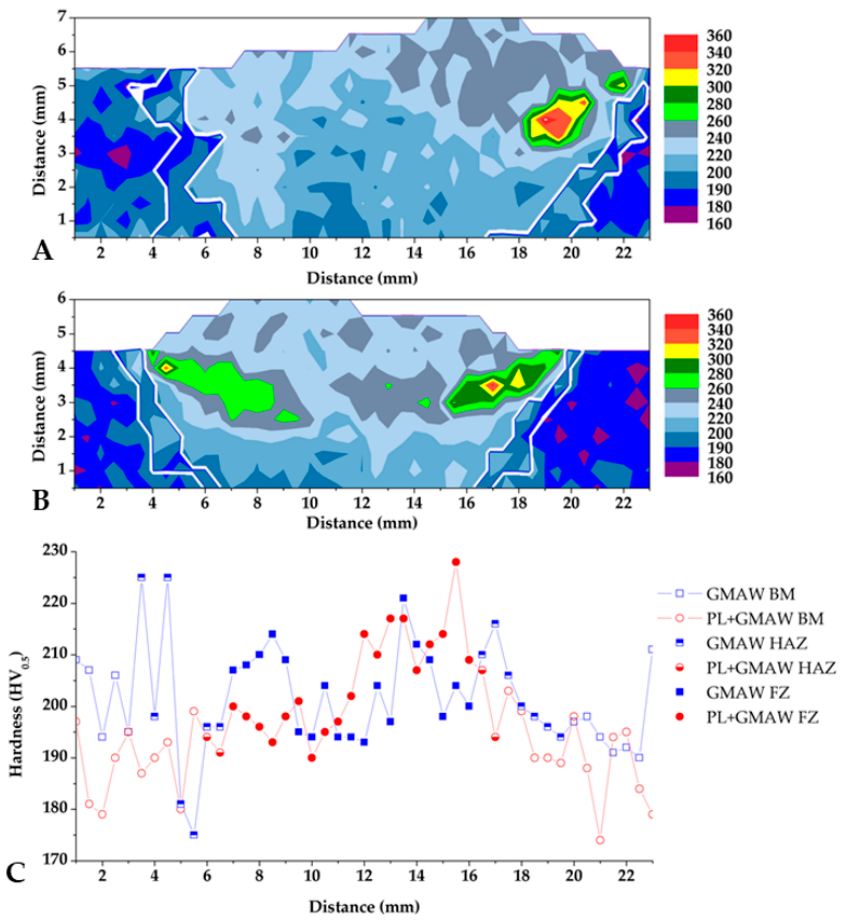
Figure 6. Microhardness mapping of GMAW ( A ), PL + GMAW ( B ), and the bottom-line profile ( C ). The white lines delimit the HAZ in ( A , B ).